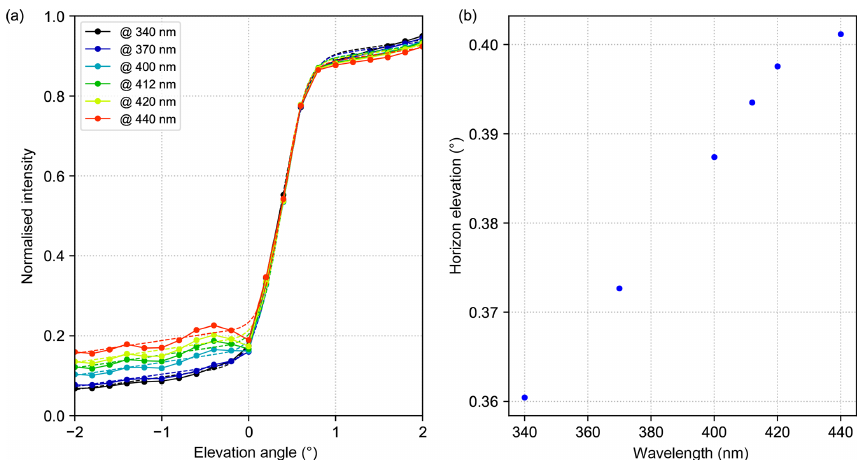
Figure 18. (a) Normalised intensity curves (coloured dots) and corresponding Gaussian integral fits (coloured dashed lines) at different wavelengths for the horizon scan performed on 17 September by the MPIC instrument. (b) Respective horizon elevations (retrieved from the fits in a ) as a function of